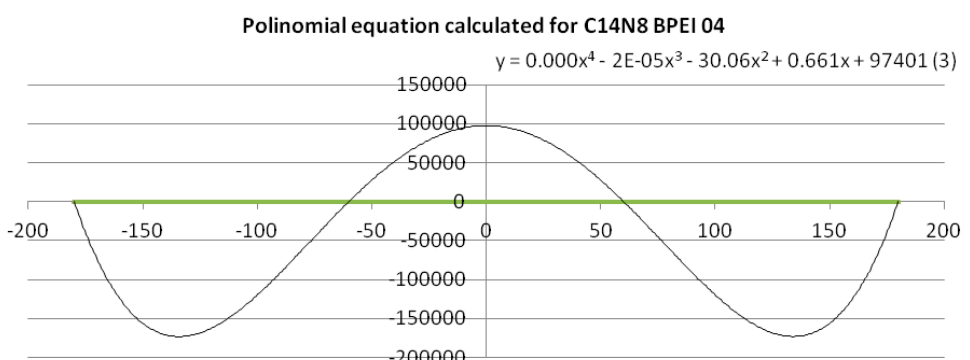
Figure 3. Polynomial equation calculated for the dihedral angles cluster of C14N8 BPEI 04 (the “(3)” number of equation corresponds with that of the Supplementary Material).